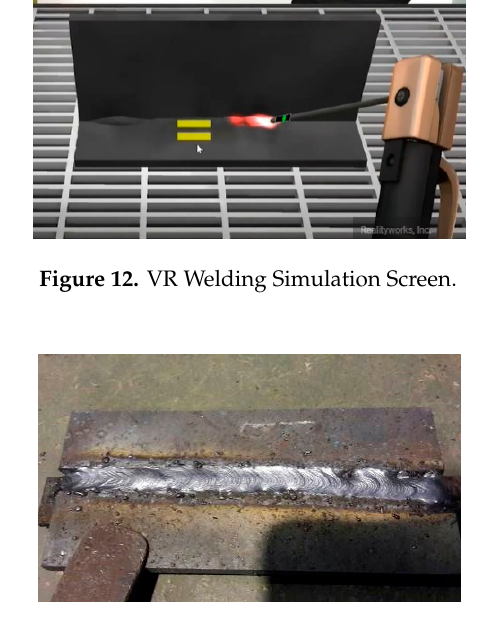
Figure 13. Student’s Make-up Examination Work.